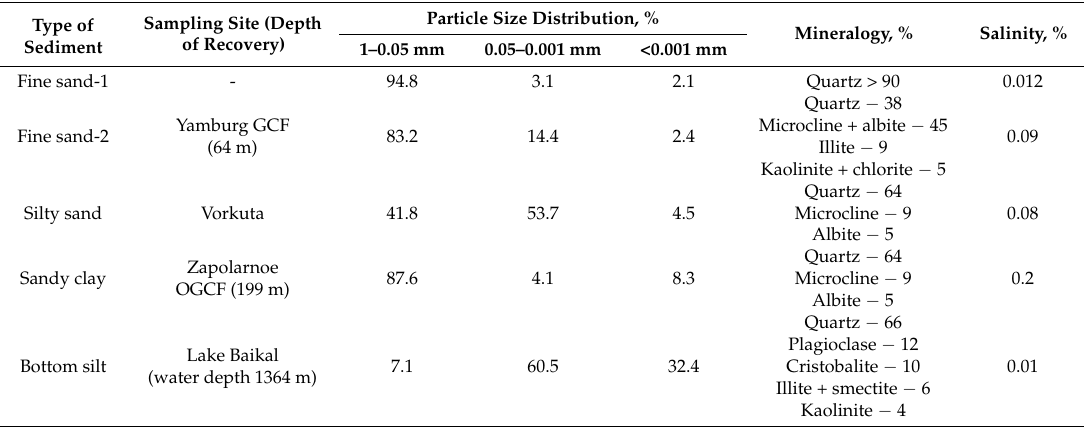
Table 1. Particle size distribution, mineral composition and salinity of